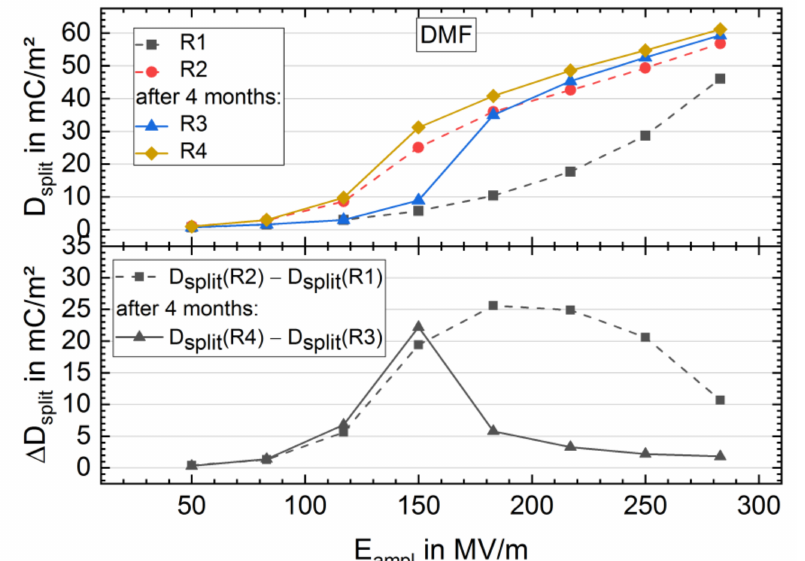
Figure 8. D-E curve gap at zero field D split vs. cycling field amplitude maximum E ampl of BE cycling run 1 to 4 (R1 to R4) for a sample from DMF solution ( top ). Between BE cycling Run 2 and 3, the sample was stored for 4 months (see Materials and Methods section). Additionally, the difference in D split vs. E ampl of R2 and R1 (dashed line) and R4 and R3 (solid line) is shown ( bottom